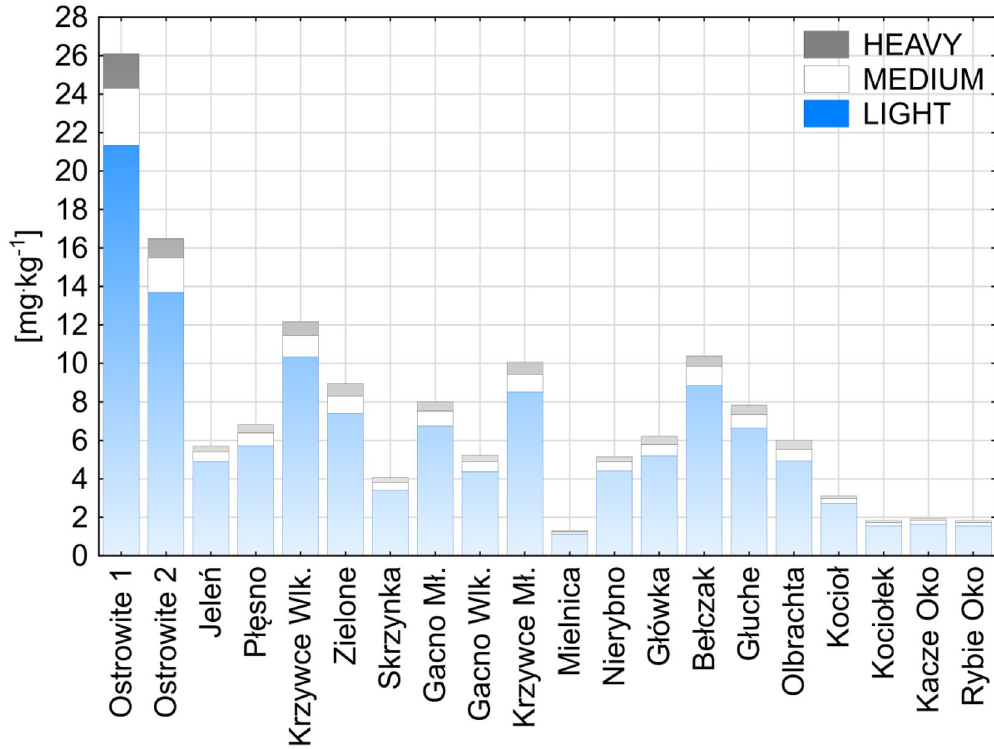
Figure 5. Cumulative REE contents in lake bottom sediments divided into light, medium and heavy fractions. Figure generated in Statistica 13. (https ://softw are.dell.com/produ cts/stati stica /).